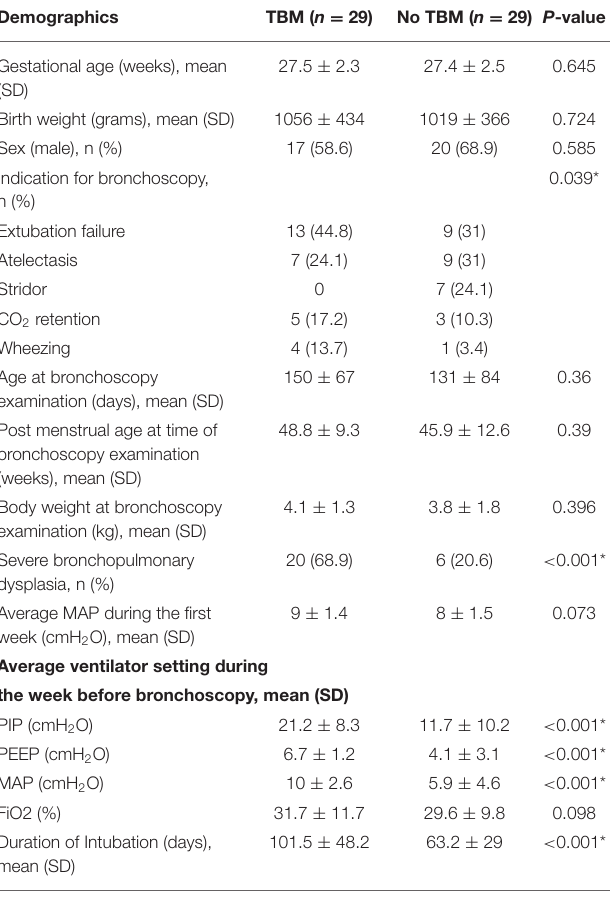
TABLE 1 | Demographic data of the preterm infants with BPD who underwent flexible bronchoscopy. Demographics